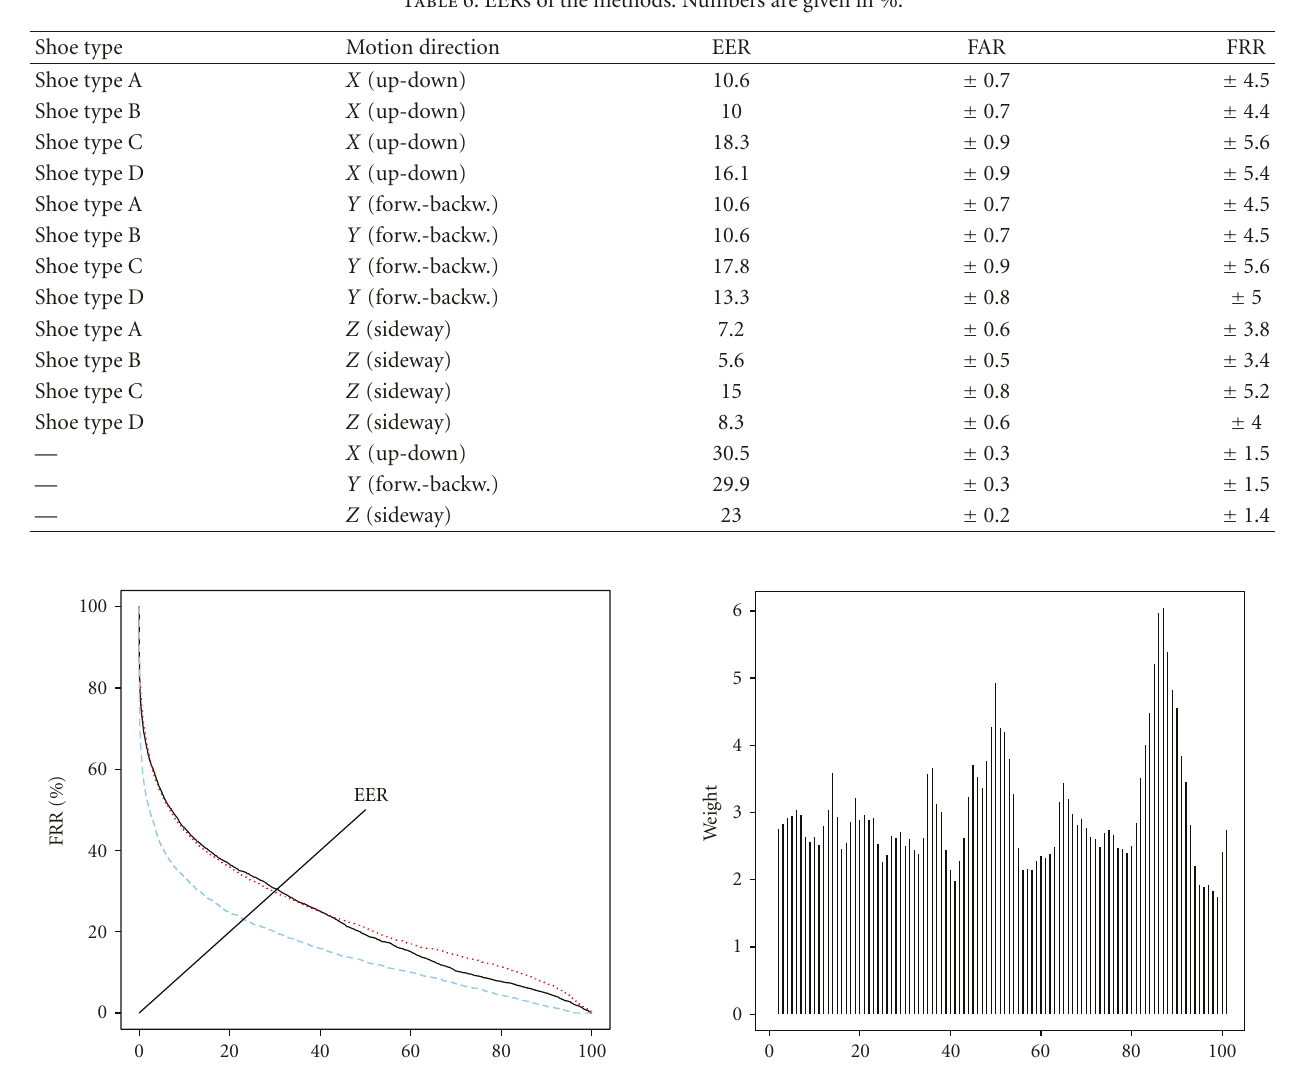
Table 6: EERs of the methods. Numbers are given in %.